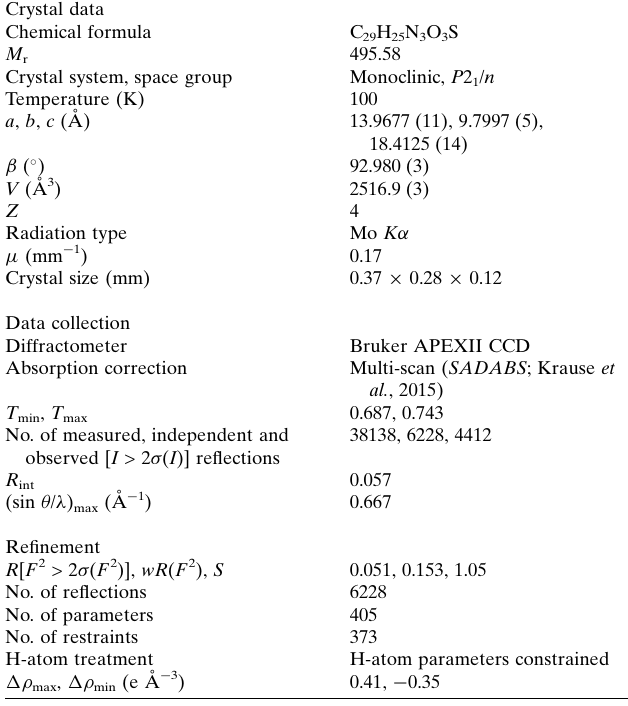
Table 2 Experimental details. Crystal data Chemical formula